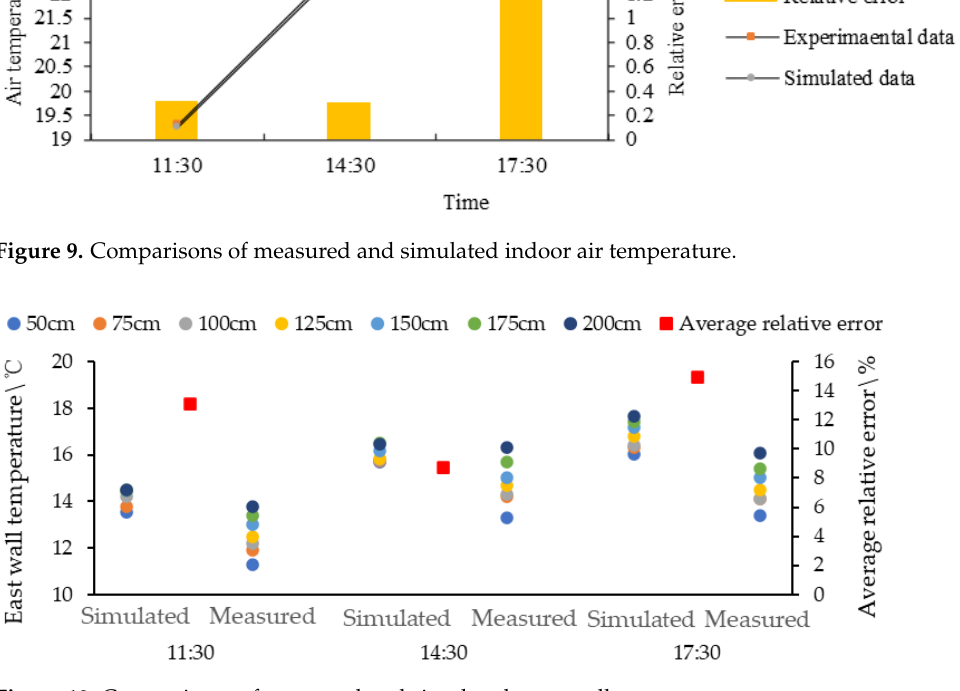
Figure 10. Comparisons of measured and simulated west wall temperature.